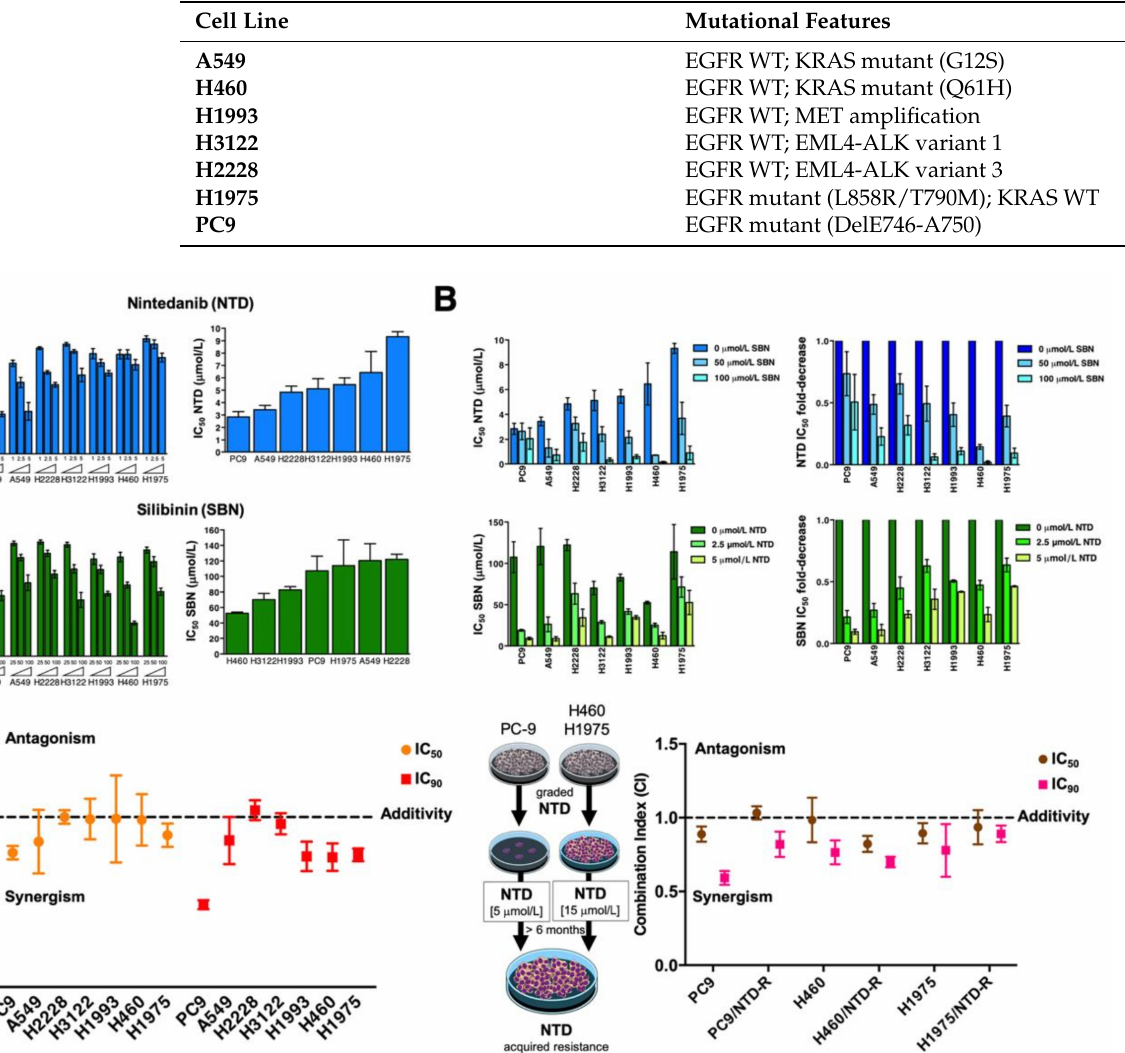
Figure 1. Analysis of the cytotoxic interaction between nintedanib and silibinin in NSCLC cells. ( A ) Left panels. The metabolic status of PC9, A549, H2228, H3122, H1993, H460, and H1975 NSCLC cell lines treated with increasing concentrations of nintedanib (NTD; 1.25, 2.5, and 5 µ mol/L) and silibinin (SBN; 25, 50, and 100 µ mol/L) was measured using MTT uptake assays, and cell viability was expressed as % uptake relative to untreated control cells (=100% cell viability). Right panels. Bar graphs of the IC 50 values for each cell line calculated from the MTT assays as described in “Materials and methods”. The results are presented as the means ( columns ) ± S.D. ( bars ) ( n = 3, in triplicate). ( B ) Left panels. Bar graphs showing the MTT-based IC 50 values of NTD ( top ) and SBN ( bottom ) for each cell line calculated in the absence or presence of graded concentrations of SBN and NTD, respectively. Right panels . Bar graphs showing the fold-change in NTD ( top ) and SBN ( bottom ) IC 50 values obtained in the absence or presence of graded concentrations of SBN and NTD, respectively. ( C ) Computed combination index (CI) values for the combination of NTD and SBN at 50% and 90% effect levels. CI values less than, equal to or greater than 1 indicates synergy, additivity or antagonism, respectively. The horizontal line at CI = 1 is the line of additivity. The results in A, B, and C panels are presented as the means ( columns ) ± S.D. ( bars ) ( n = 3, in